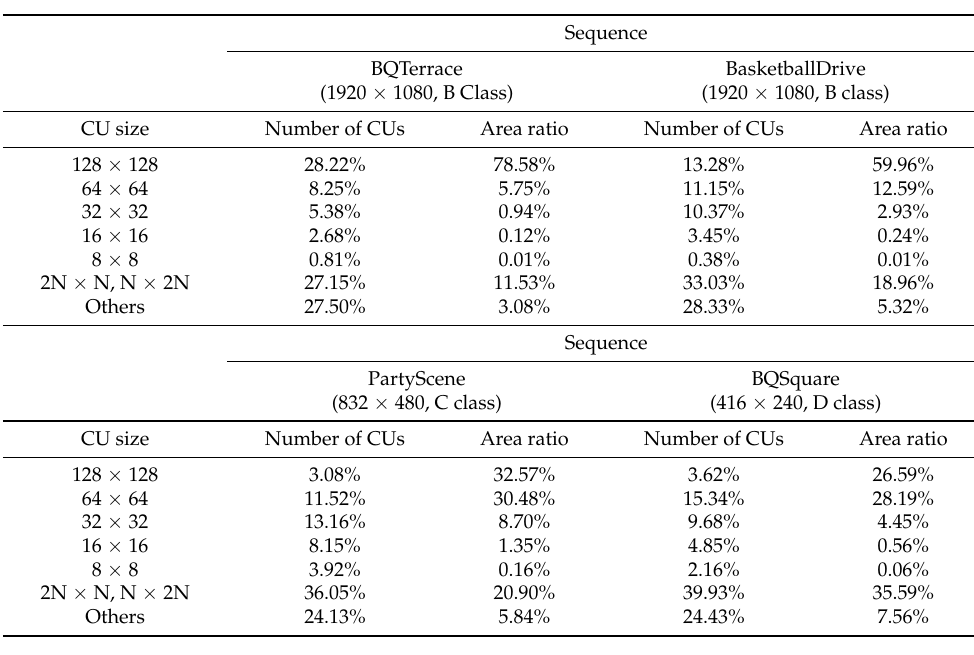
Table 2. The number of CUs and area ratio for different CU size in bi-prediction under RA and